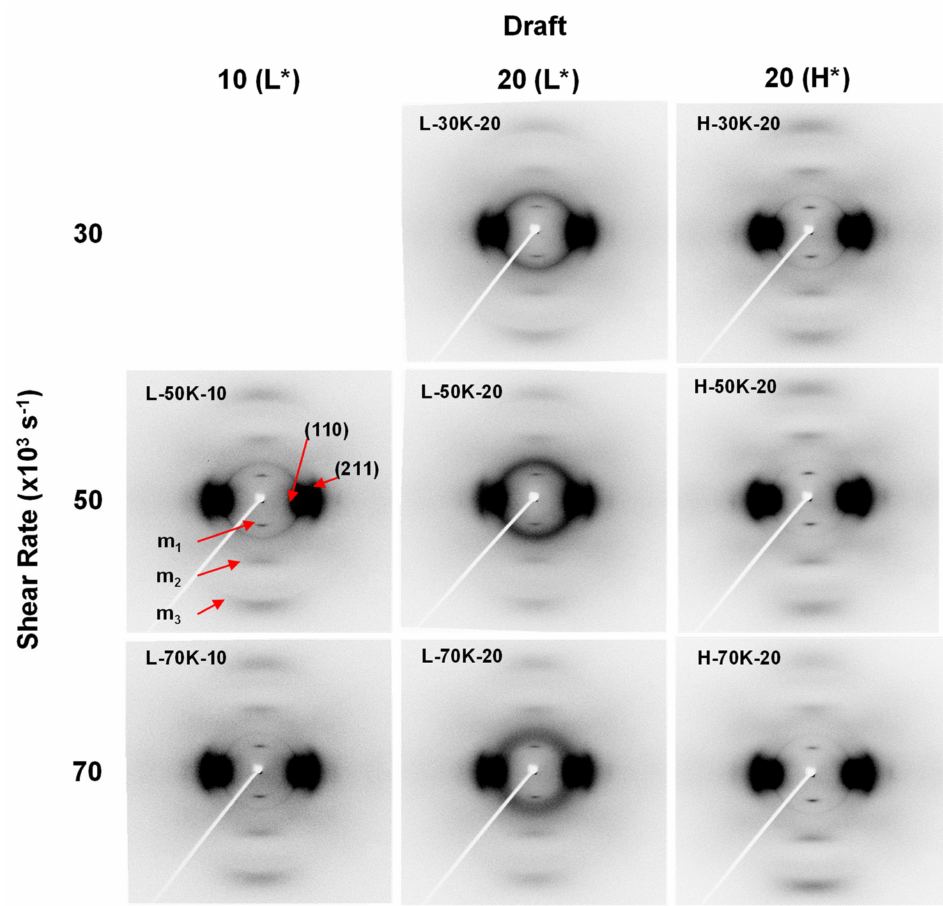
Figure 6. Two-dimensional WAXD patterns of as-spun TLCP fibers obtained at various spinning conditions. L* and H* indicate the spinning temperatures of 285 and 295 ◦ C,